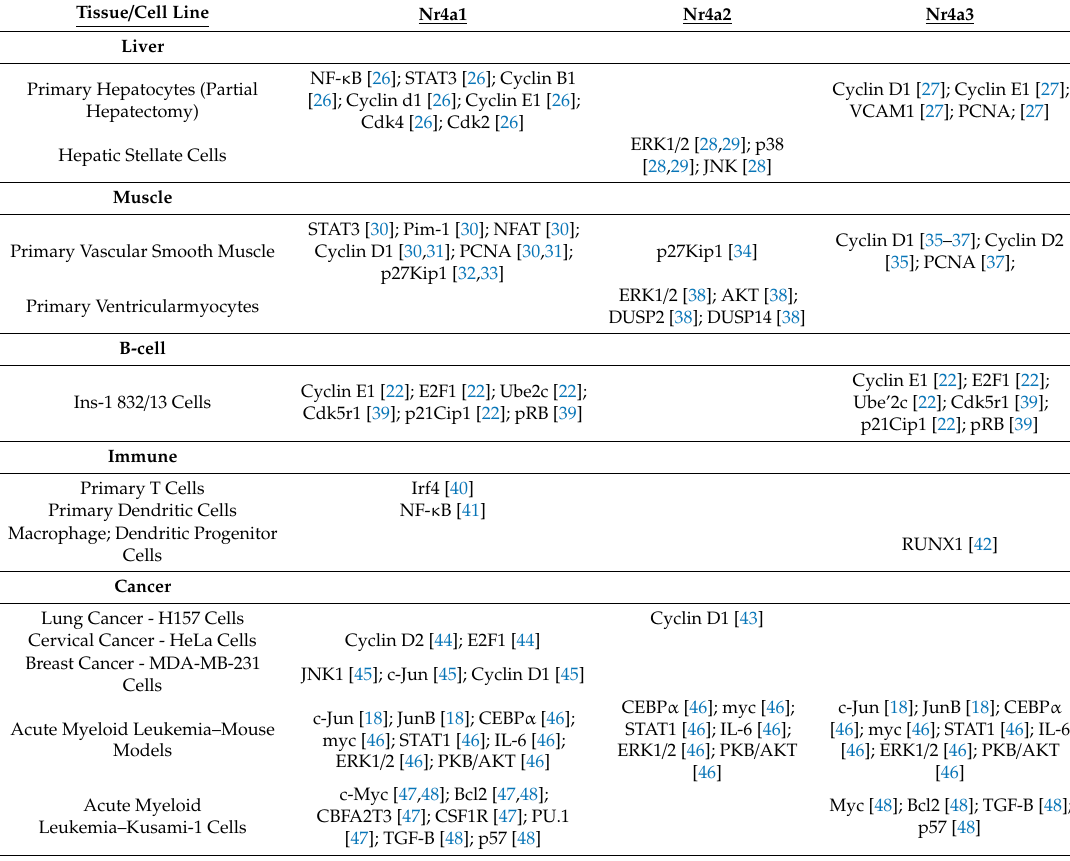
Table 1. Genes regulated by the Nr4a’s that are associated with cellular proliferation, defined by tissue of interest. References are given for each